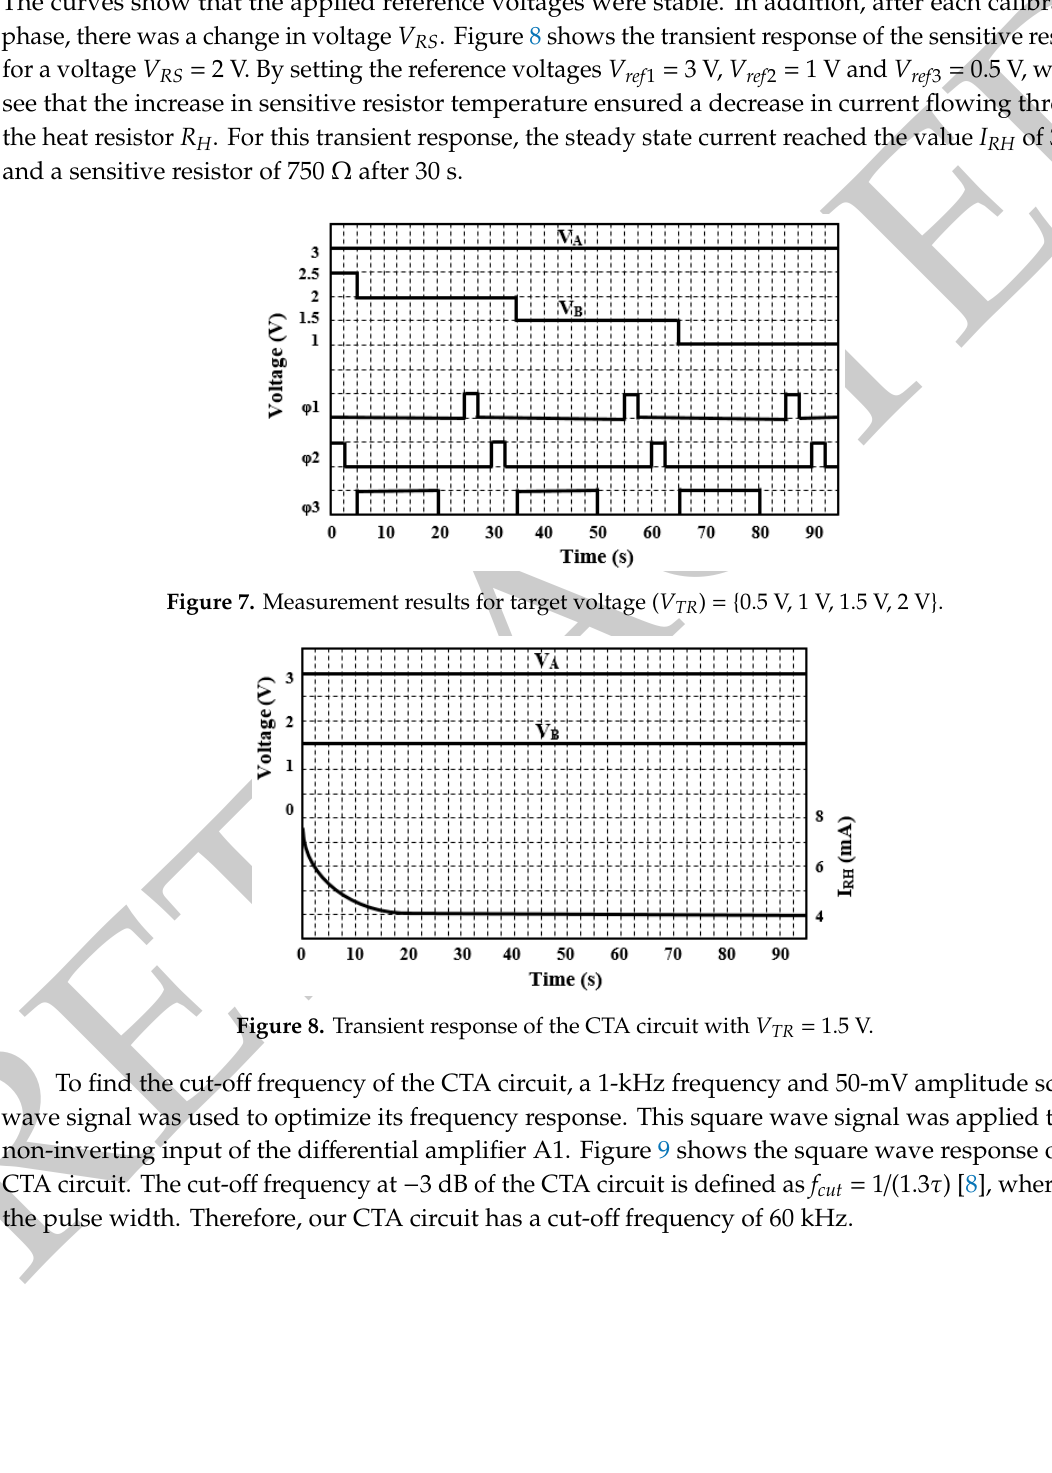
Figure 9. Square-wave time response of the CTA circuit.